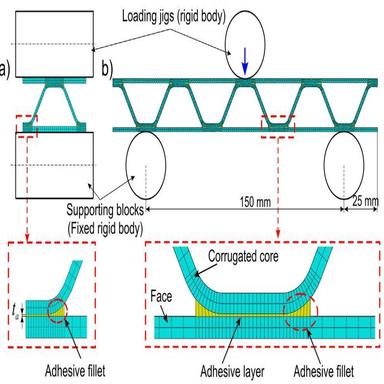
FEMs of the ABCSS with detailed mesh refinement of adhesive layer: a) Longitudinal and b).